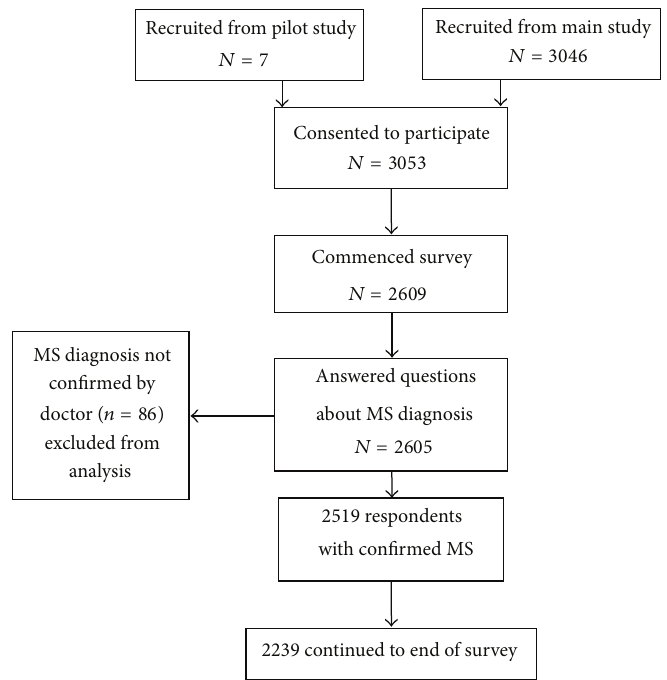
Figure 1: Participant study inclusion